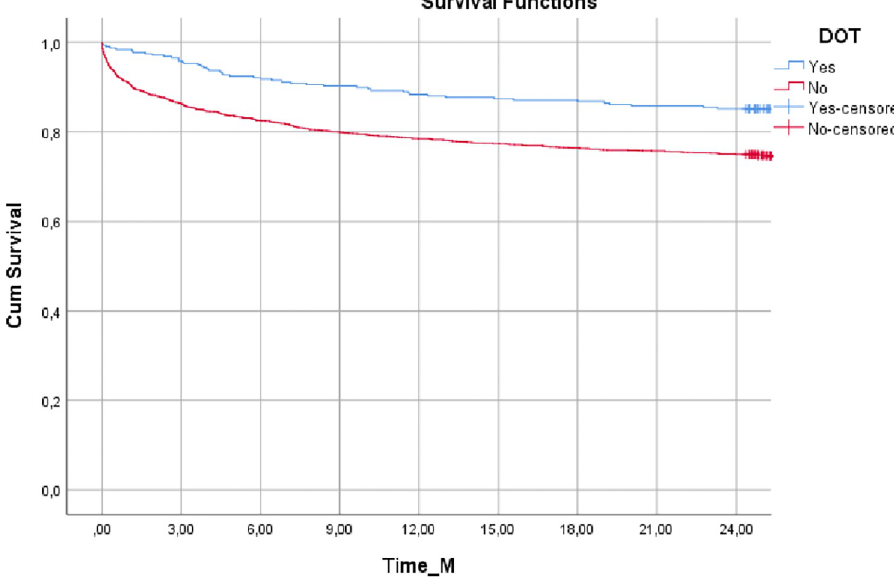
Fig 2. Survival curves adjusted according to the performance of DOT in cases of TB/HIV coinfection between 2009 and 2013, in Porto Alegre, Brazil. � p < 0.001. Log-Rank test performed at 5% significance level.